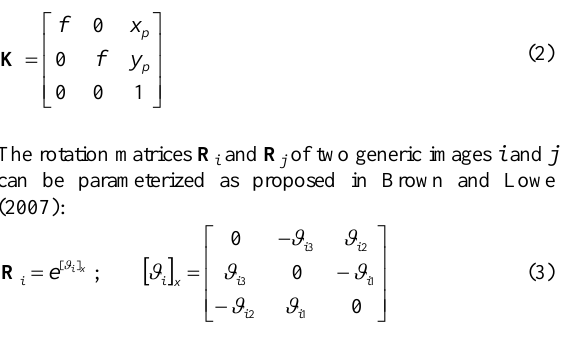
Fig. 2. Generation of a gnomonic projection, i.e. a non conformal mapping where great circles are mapped to straight lines. It replicates the effect of image acquisition by means of spherical